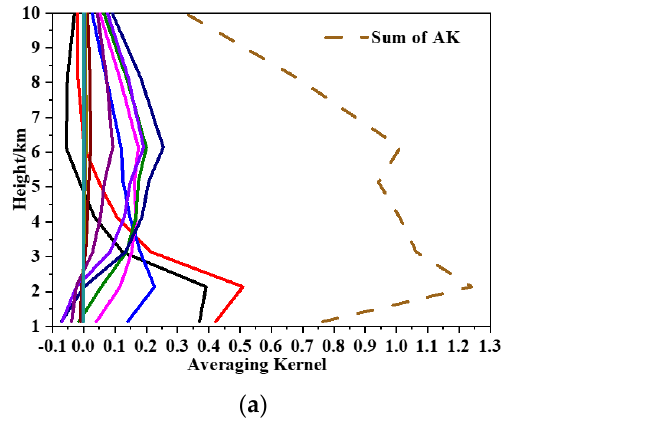
Figure 14. Averaging Kernel of ( a ) HDO and ( b ) CH 4 .